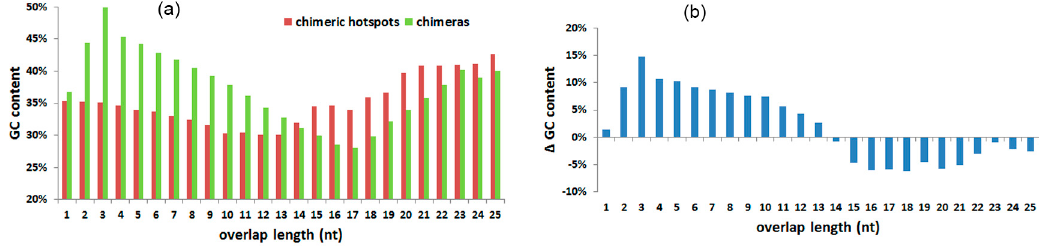
Figure 4. Average overlap GC content in overlap length. ( a ) Average overlap GC content in chimeras and chimeric hotspots in overlap length; ( b ) Δ GC between chimeras and chimeric hotspots in different overlap lengths.